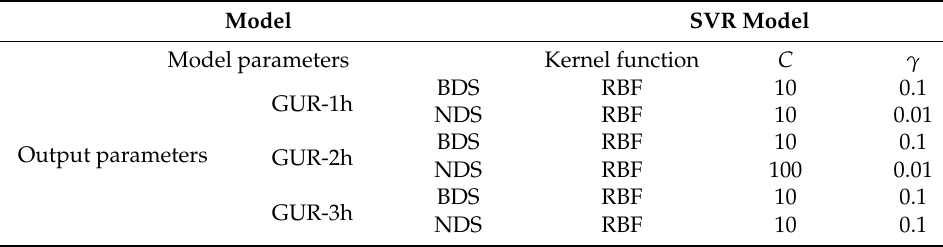
Table 3. The best hyperparameters of the SVR model based on the two data